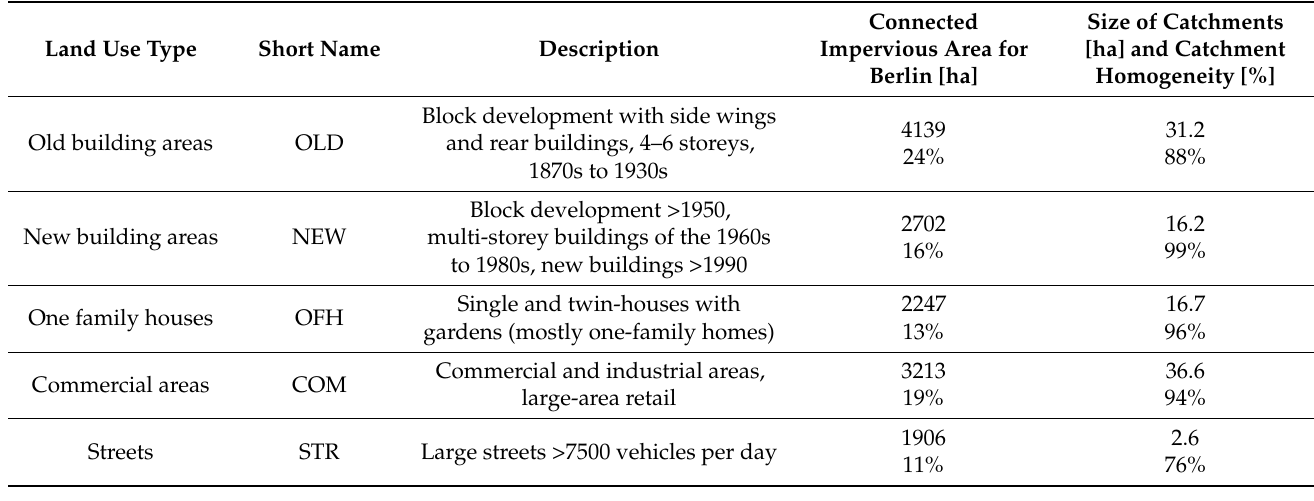
Table 1. Land-use types in Berlin considered for monitoring. All land use types beside streets (STR) include small residential roads <7500 vehicles per day.